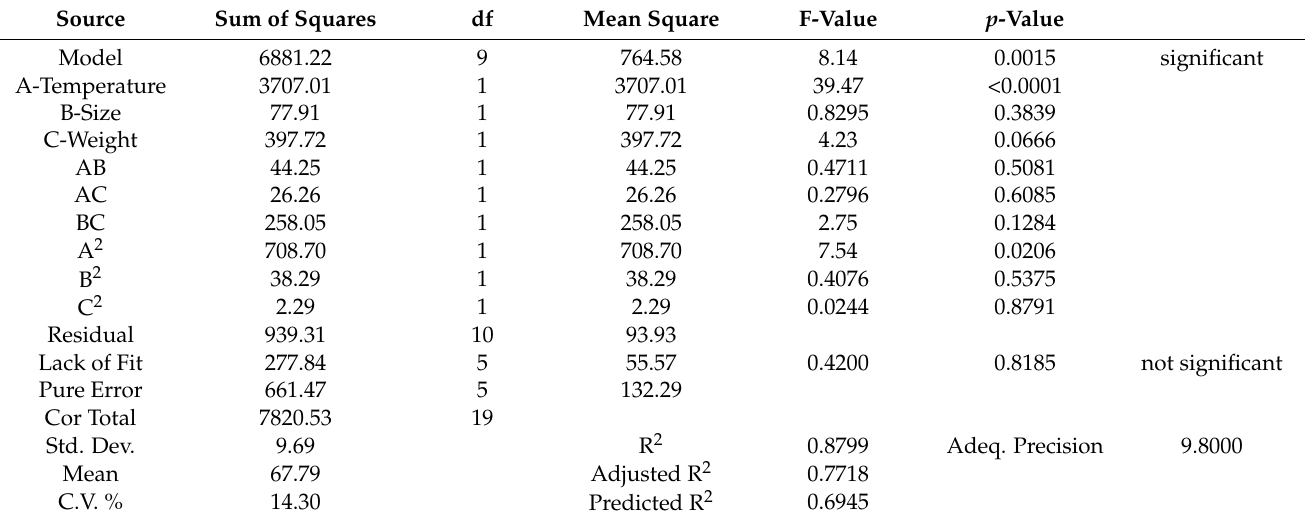
Table 2. The experimental results from the CCD quadratic model for dye decolourisation of RTDW.